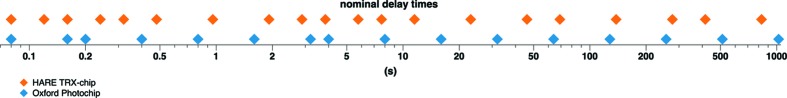
HARE delay times that can be addressed with the HARE chip and the Oxford photochip. The figure illustrates the discrete time points that can be addressed with the Oxford photochip (blue) and the HARE chip (orange) without changing any experimental parameter other than the time delay between reaction initiation pump and probe. Time delays are calculated for a translation-stage frequency of 25 Hz.